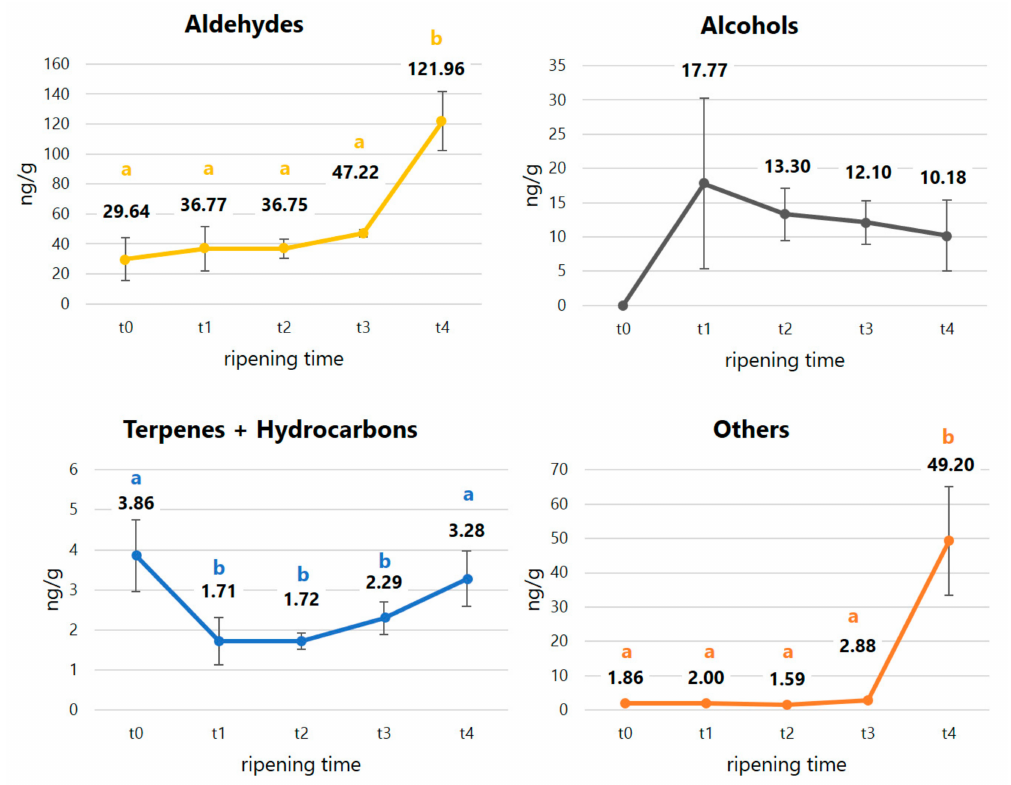
Figure 3. Development of the volatile compounds profile among t0 (raw eggs) and t4 (240 days) in caviar samples analysed by